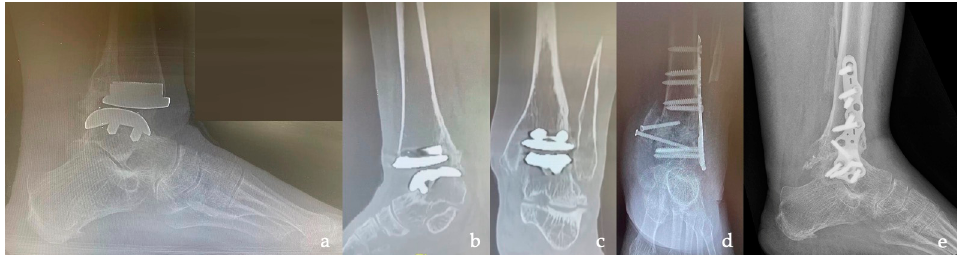
Figure 3. A 55-year-old man with severe osteoarthritis (OA) and deformity of the right ankle and a history of rheumatoid arthritis, diabetes mellitus, and venous insufficiency. ( a – c ) Pre-operative X-ray in the lateral and anteroposterior view. ( d , e ) Pre-operative CT scan showing severe OA of the TT joint. ( f , g ) Anteroposterior and lateral X-ray at 3 months of follow-up from tibiotalocalcaneal (TTC) arthrodesis. Regarding the alignment of the ankle and hindfoot, all of the evaluated angles (ADTA, TTA, CTTA, and HAA), which had a pathological value before surgery, were in the physio- Table 2. Pre-operative and last follow-up mean values with standard deviation and ranges. logical range